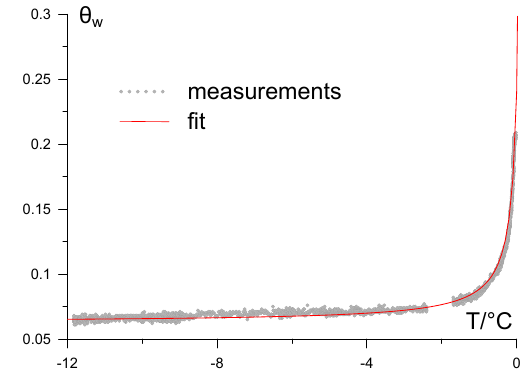
Fig. 2. Soil freezing characteristic (volumetric water content θ w vs. temperature T ) as inferred from measurements of volumetric water content and temperature at a depth of 0.89m at the Bayelva station in the years 2009 and 2010. The fit follows Eq.